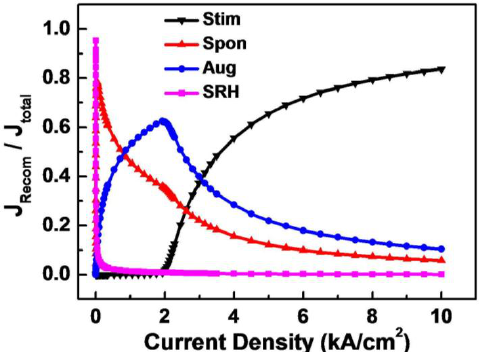
Figure 5. The calculated curves for the ratio of stimulated emission current (black), spontaneous emission current (red), Auger recombination current (blue), and SRH recombination current (magenta) over the total injection current in GaN-based LDs.